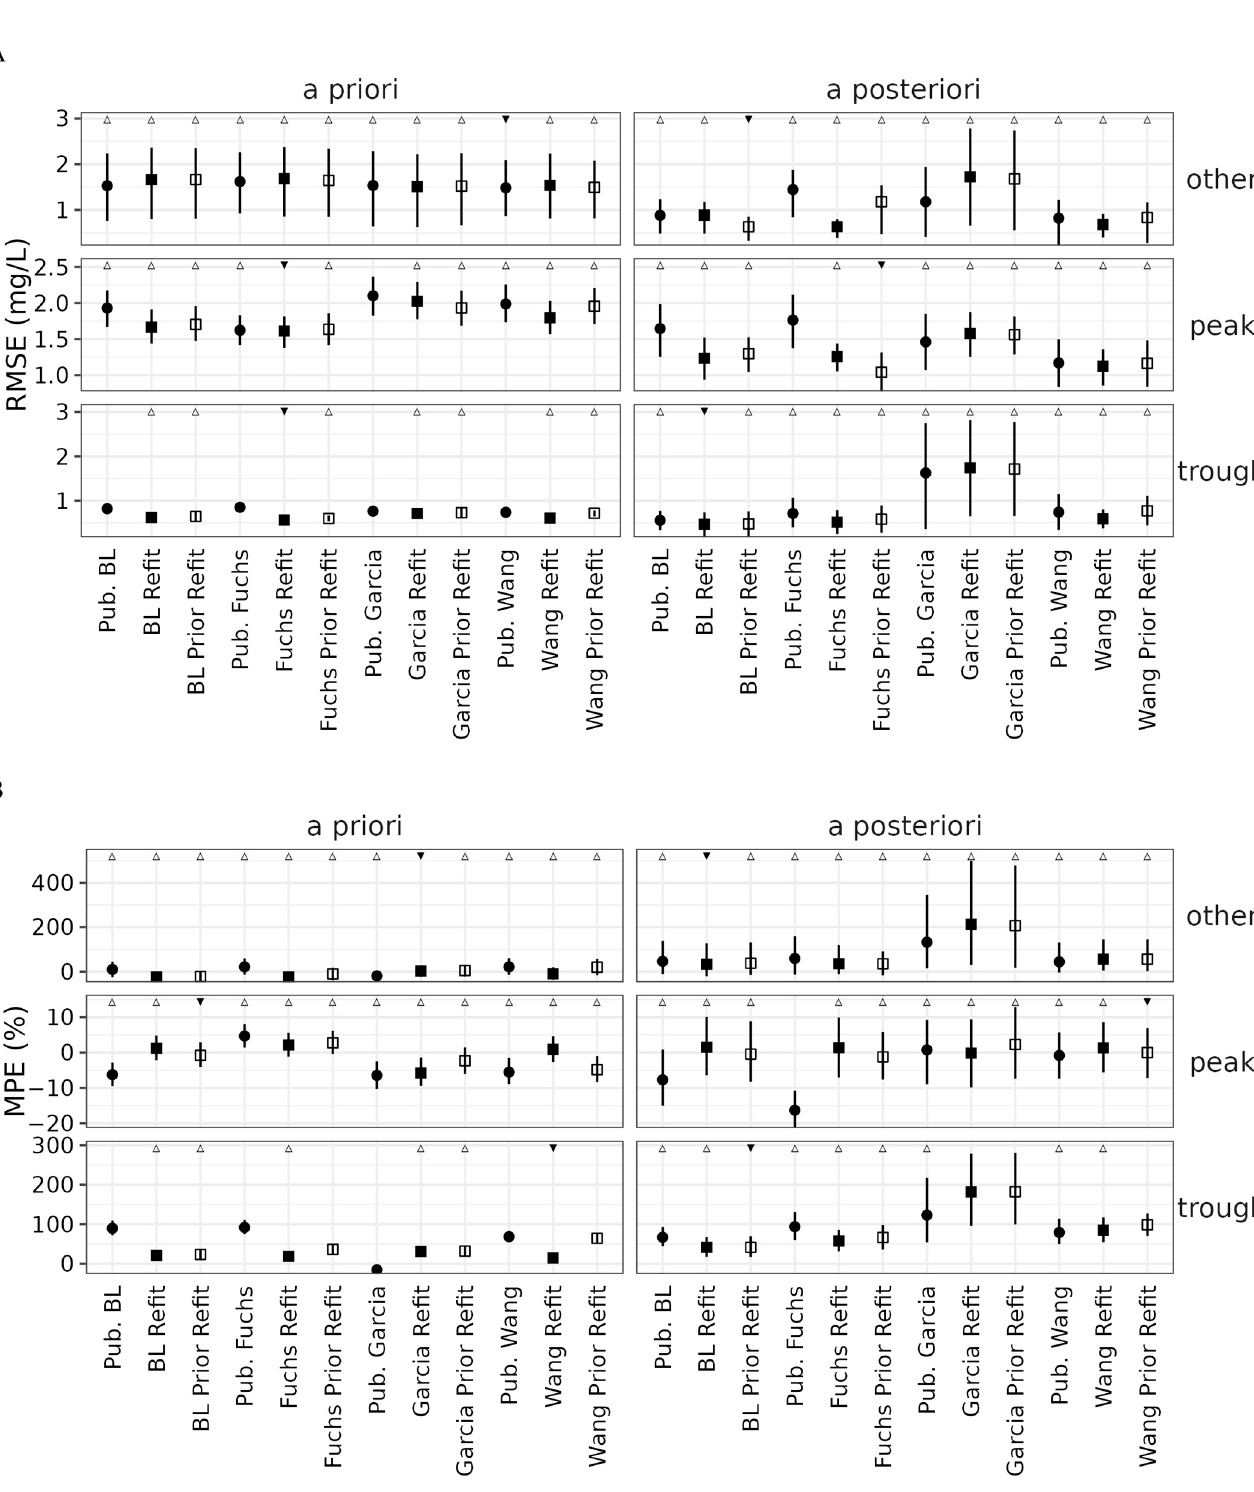
Figure 7. ( A ) Root mean square error (RMSE) and ( B ) mean percent error (MPE) on testing data for published models (circles), fully refit models (filled squares), and models refit with $PRIOR in NONMEM (hollow squares). Closed circles (vertical bars) represent the median (5th to 95th percentile) of 1000 bootstraps. Statistical significance was determined by presence of overlapping confidence intervals: ▼ represents the model with lowest median RMSE or lowest absolute median MPE in that category; △ represents models not statistically different from the best model. BL: Bijleveld.